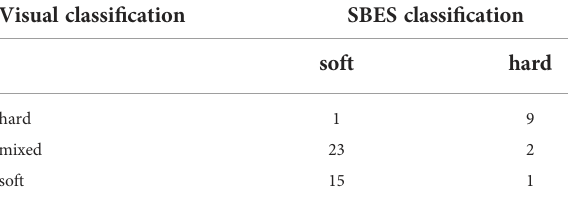
TABLE 3 Comparison of visual and acoustic classi fi cation of bottom.